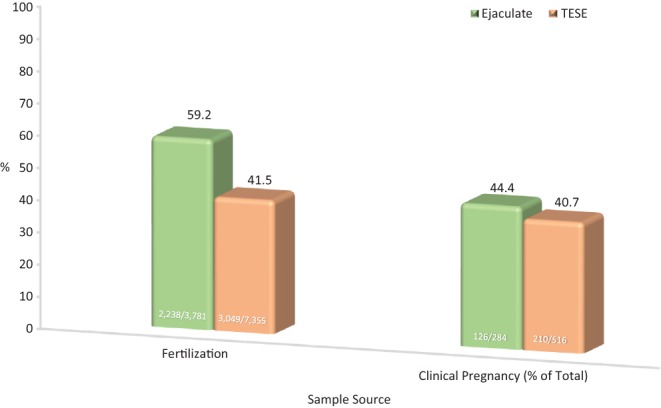
Comparison of fertilization and clinical pregnancy rates in cases with few spermatozoa identified. In 986 cycles, extremely few spermatozoa were seen after high-speed centrifugation. Samples were searched for injectable spermatozoa in drops under oil for up to several hours by multiple embryologists until all oocytes were injected. Oocytes injected with ejaculate spermatozoa demonstrated a higher fertilization rate compared to those injected with testicular specimen (χ2, 2 × 2, 1 df; P < 0.0001). Clinical pregnancy rates remained comparable between the two sperm sources.